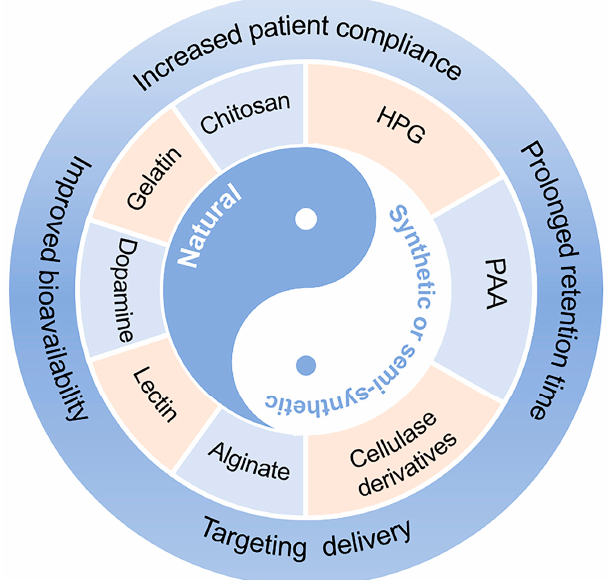
Figure 1. Bioadhesive nanoparticles (NPs) based on different materials. HPG: hyperbranched polyglycerol; PAA: poly (acrylic